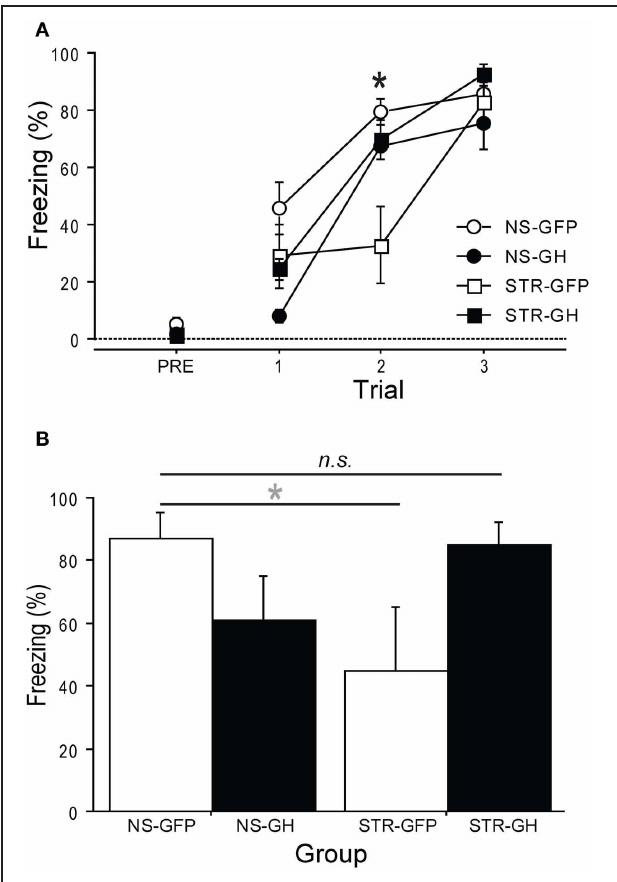
FIGURE 4 | Overexpression of hippocampal GH rescues stress-related impairments in contextual conditioning. Ten days of daily immobilization stress (STR) or handling (NS) were administered to rats. Twenty-four hours after the last session, GH or GFP virus was infused bilaterally into the dorsal hippocampus. (NS-GFP, n = 4; NS-GH, n = 3; STR-GFP, n = 4; STR-GH, n = 3). (A) After three days of recovery, contextual fear conditioning was administered. Stress slowed contextual fear acquisition ( ∗ Indicates p < 0 . 05 in post-hoc comparisons between STR-GFP and other groups), and this was prevented by intra-hippocampal GH. In contrast, intra-hippocampal GH had no effect in unstressed control rats. (B) The next day, the rats were returned to the context for an 8m context extinction session. Stress impaired long-term contextual fear memory, and this impairment was rescued by expression of GH in the dorsal hippocampus. In contrast, intra-hippocampal GH tended to produce a mild impairment of long-term contextual fear memory in unstressed control rats. ∗ Indicates p < 0 . 1 in a post-hoc comparison. controls ( p = 0 . 09; post-hoc comparison). These results